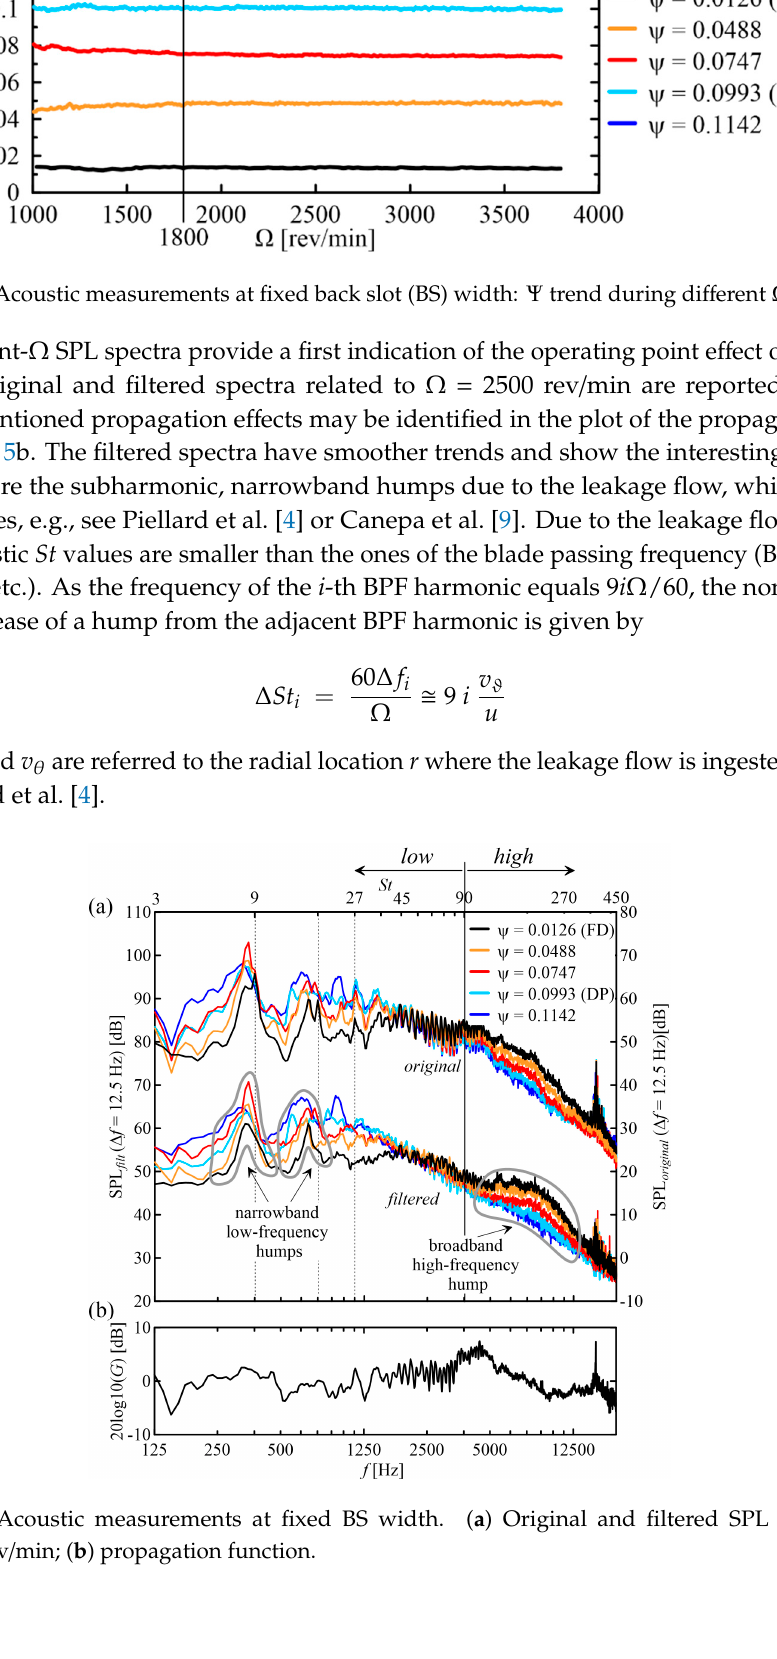
Figure 4. Acoustic measurements at fixed back slot (BS) width: Ψ trend during different Ω ramps.